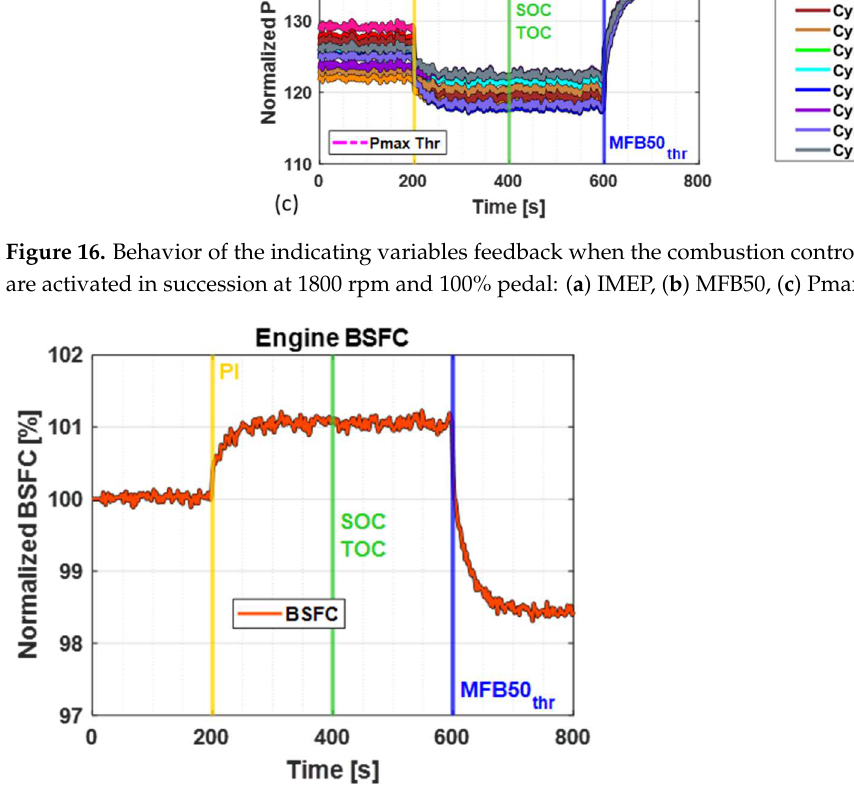
Figure 18 . Test engine conditions with on left axis the pedal, and on the right axis the engine speed. In Figures 19b–d and 20b–d, the error is calculated as the difference between the tar- get and the measured values. The graphs in Figures 19 and 20 show that the auto-adapta- tion strategies on TOC and on SOC can compensate the undesired effects due to aging or cylinder disparity not only under steady-state conditions but also under transient condi- tions. In fact, while the IMEP error before the adaptation of TOC is between −0.63 bar and +1.2 bar, after the adaptation, it is within ±0.08 bar. The same can be said for the MFB50, where the error variation range decreases from 2.6 °CA, before the SOC adaptation, to 0.8 °CA after the SOC adaptation.